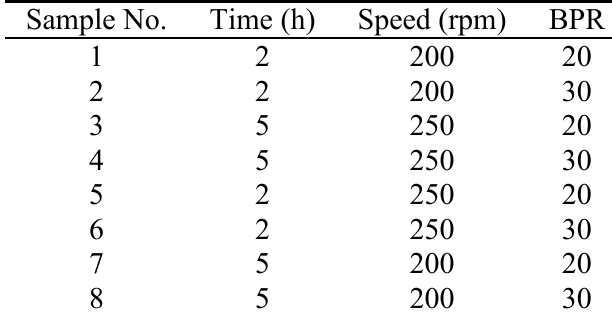
The conditions of the tests suggested by Taguchi